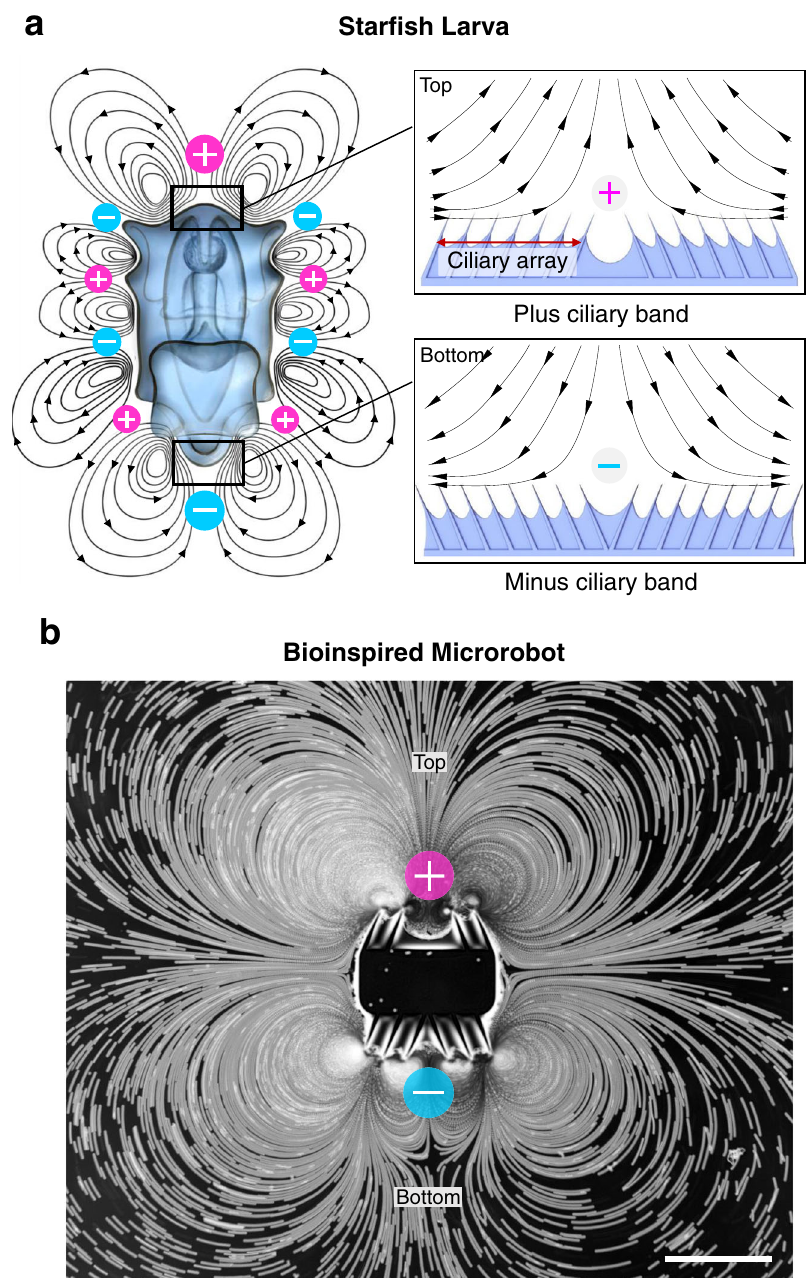
Fig. 1 Star fi sh larva-inspired ultrasound ciliary band designs. a A star fi sh larva exhibits a complex fl ow pro fi le of counter-rotating vortices generated by a series of + and − ciliary bands arranged on its body protuberances. Inset: (top) A + ciliary band comprises a pair of angled ciliary arrays that face each other and causes the liquid to fl ow away on a plane perpendicular to the center of the ciliary band. (Bottom) A − ciliary band consists of two ciliary arrays oriented away from each other and directs the liquid fl ow to the center of the band. b A star fi sh-inspired microrobot consisting of a + (top) and a − (bottom) ciliary band placed in a tracer solution. The ciliary bands oscillate when actuated by ultrasound, producing complex fl ow pro fi les similar to those observed with its biological counterpart. Scale bar, 250 μ